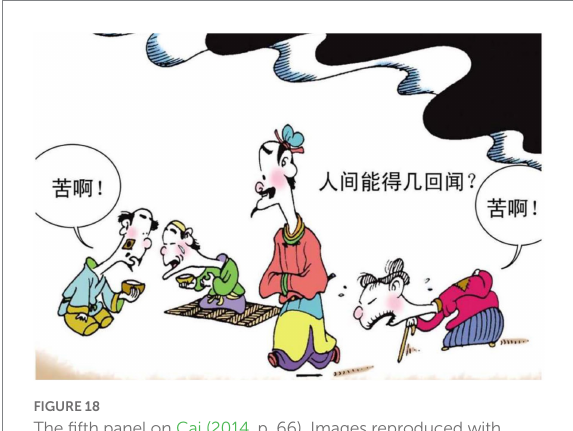
FIGURE 18 The fifth panel on Cai (2014, p. 66). Images reproduced with permission from Shang Dong People